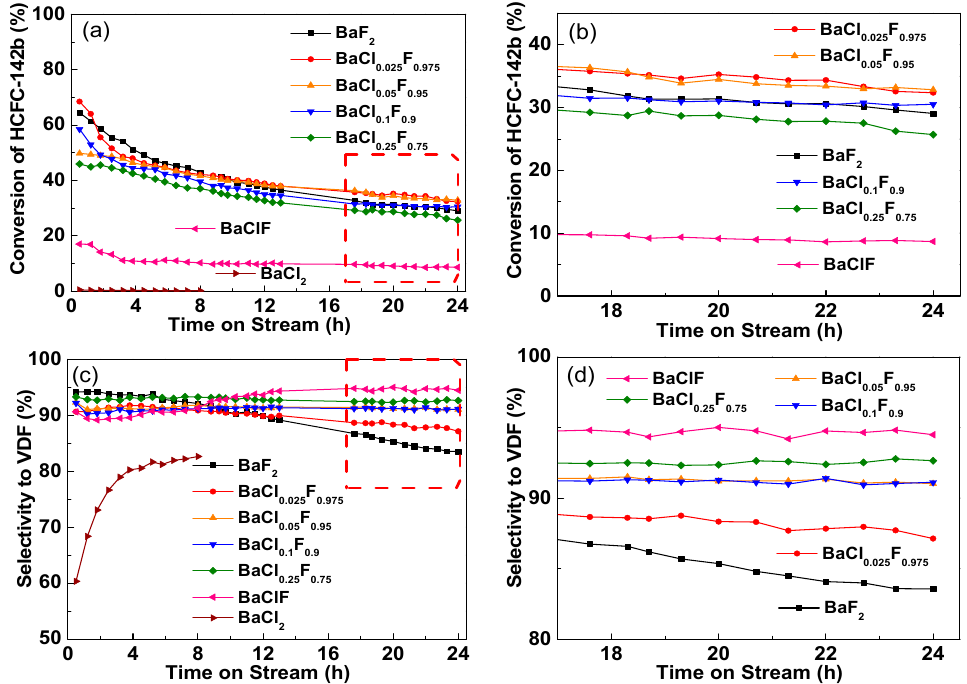
Figure 1. Catalytic performance of BaCl x F y catalysts for the pyrolysis of HCFC-142b as a function of time on stream at atmospheric pressure, a gas hourly space velocity (GHSV) of 1200 h − 1 , and a reaction temperature of 350 °C. ( a ) Conversion of HCFC-142b, ( b ) Highlighted conversion of HCFC-142b for the time on stream between 14 and 24 h, ( c ) Selectivity to vinylidene fluoride (VDF) and ( d ) Highlighted selectivity to VDF for the time on stream between 14 and 24 h.